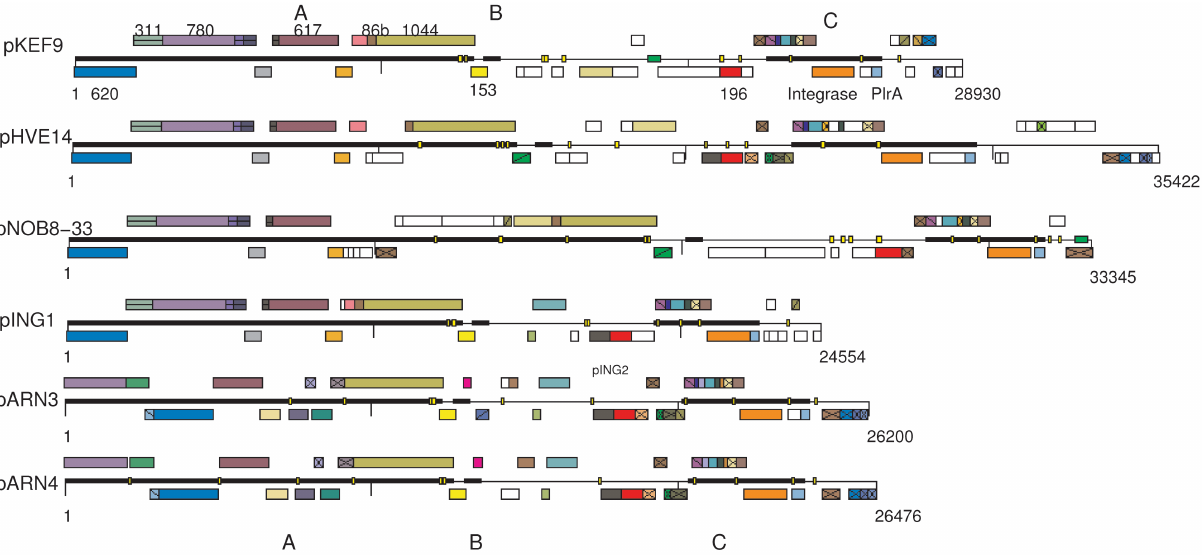
Figure 1. Comparative gene map of the Sulfolobus self-transmissable plasmids. Thick, black horizontal lines delineate the genomic sections A, B and C. The main conserved open reading frames (ORFs) in section A, the highly conserved ORF153 and ORF196, the integrase and PlrA are la- beled for pKEF9. Homologs in the different plasmids can be identified by color and pattern. Open reading frames shown as an empty box have no homologs in the other plasmids. The short regularly spaced repeat (SRSR) clusters are indicated by green rectangular boxes on the linear genomes of pKEF9 and pNOB8-33. Recombination motifs are represented by yellow boxes on the linear genomes. The location of the deletion in pNOB8-33 is downstream from ORF617. The deletion variant plasmid pING2 extends from downstream of ORF1044 to the center of the operon in section C.